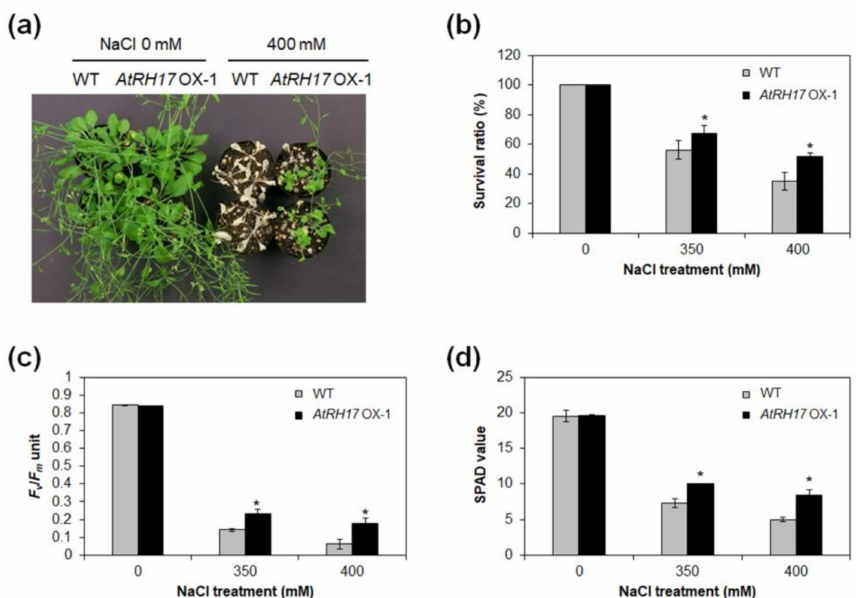
Figure 7. Salt-stress response of AtRH17 OX mature plants. ( a ) Three-week-old WT and AtRH17 OX-1 plants were watered with 0, 350, and 400 mM NaCl. Photograph was taken after 20-day NaCl treatments. ( b ) Survival ratio of WT and AtRH17 OX-1 treated with 0, 350, and 400 mM NaCl for 20 days. ( c ) PS II activity ( F v / F m ) of WT and AtRH17 OX-1 treated with 0, 350, and 400 mM NaCl for 17 days. ( d ) SPAD values of WT and AtRH17 OX-1 treated with 0, 350, and 400 mM NaCl for 17 days. Error bars represent standard deviation ( n = 30 plants) and * indicate t -test p < 0.05. Three independent T 1 lines showed similar results, with one shown